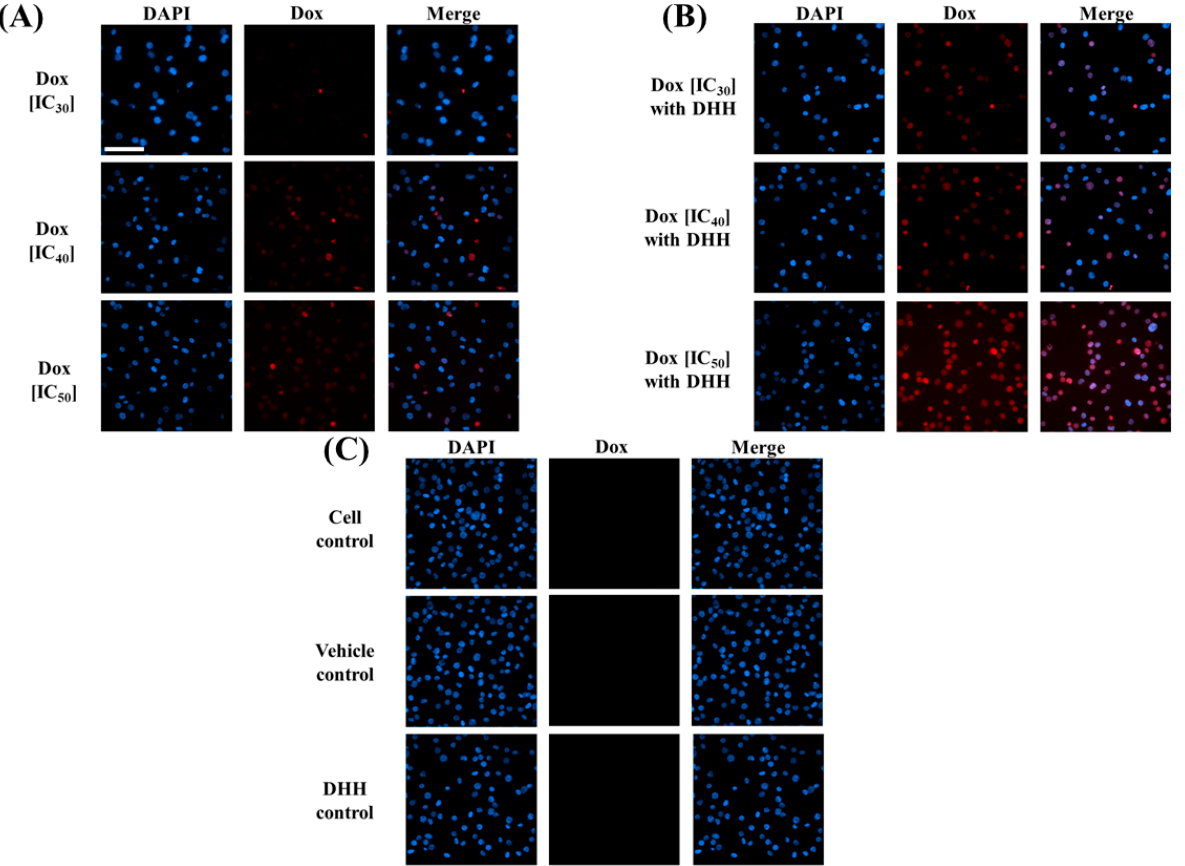
Figure 6. Dox accumulation in K562/ADR cells under fluorescence microscope (scale bar, 100 µm): ( A ) K562/ADR cells were treated with Dox at various concentrations; ( B ) K562/ADR cells were co- treated with Dox at various concentrations (33.1, 40.9, and 51.6 µM) and DHH (55.6 µM); ( C ) cell control, vehicle control, and DHH control showed no autofluorescence interference to DOX fluores- cence intensity.